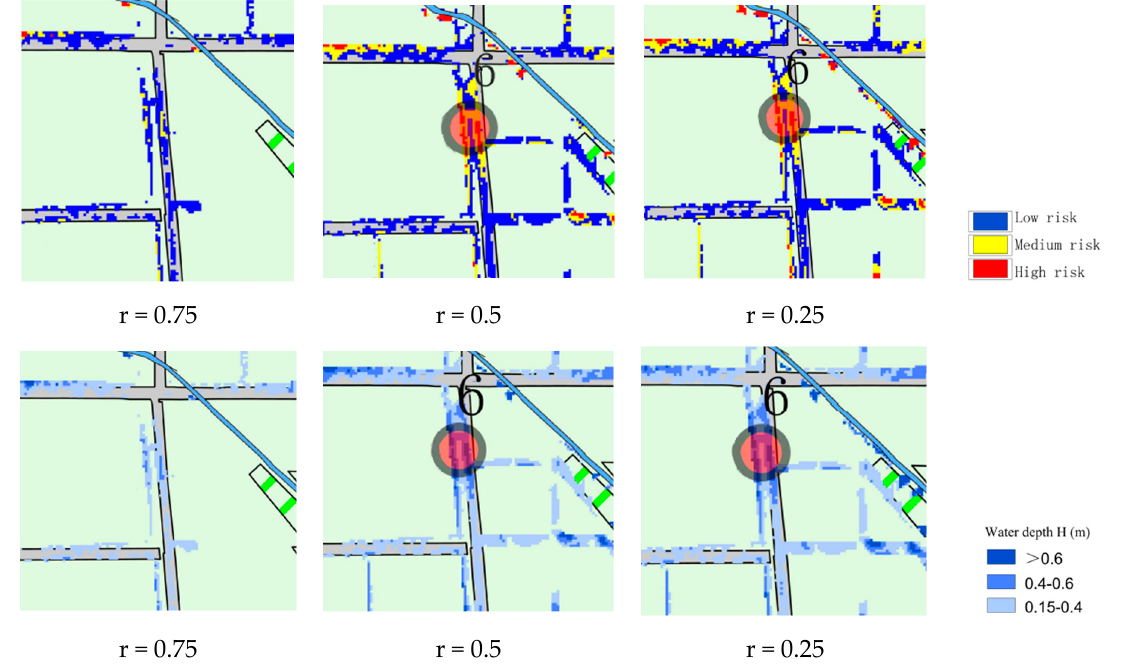
Figure 6. Map of the risk of local flooding under different rainfall patterns for the 1 in 10 year